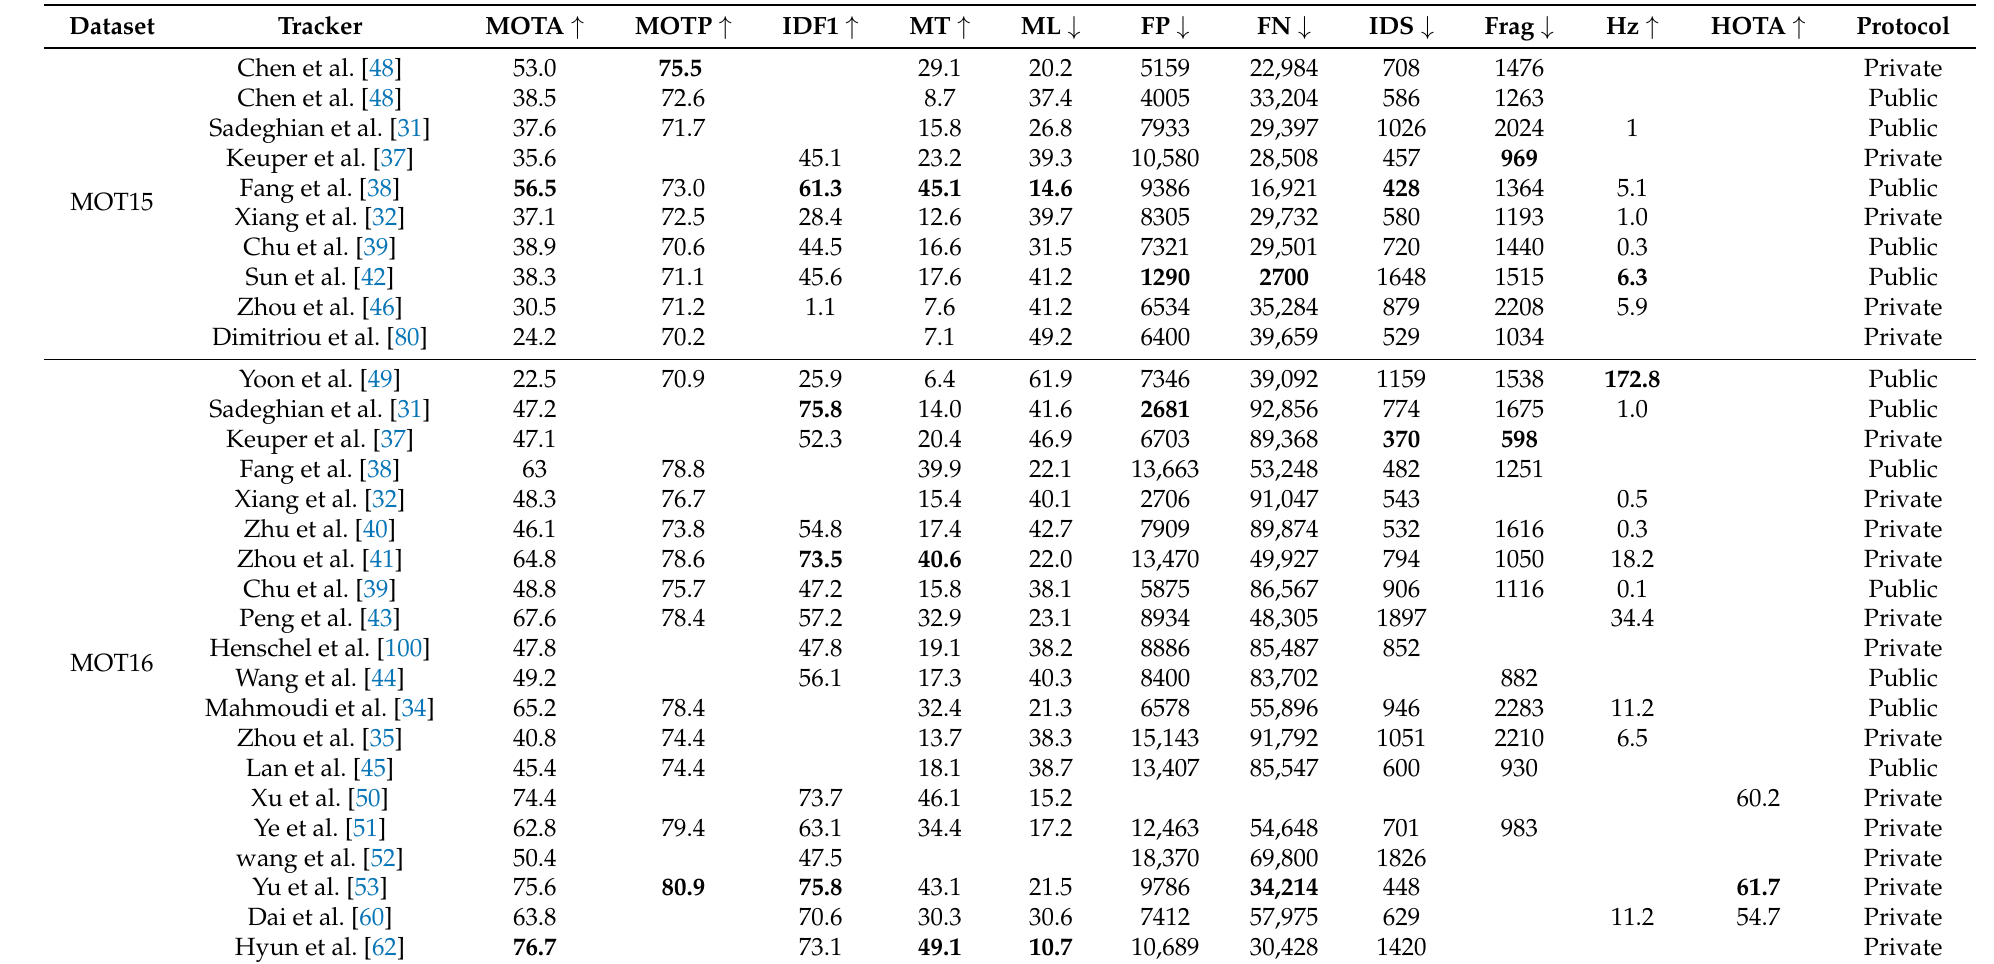
Table 5. The performance using the MOT15, 16, 17, and 20